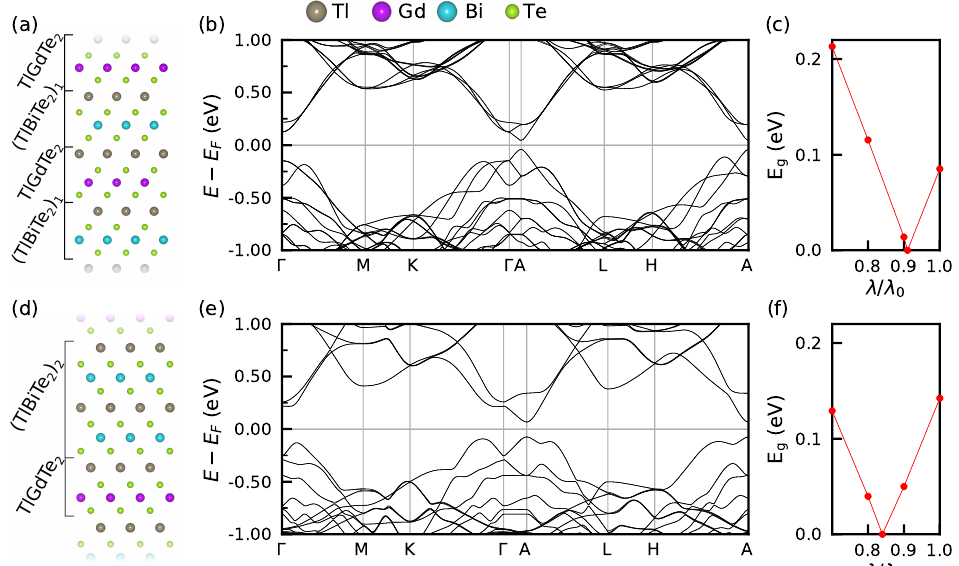
Figure 3. ( a , d ) Crystal structures of the TlGdTe 2 /(TlBiTe 2 ) n superlattices for n = 1 ( a ) and n = 2 ( d ). ( b , e ) Bulk electronic structure of the TlGdTe 2 /(TlBiTe 2 ) n superlattices for n = 1 ( b ) and n = 2 ( e ). Note that the number of bands is larger for the n = 1 system due to a larger number of the atoms in the hexagonal unit cell: 24 for n = 1 vs. 12 for n = 2. This is because the ABCABC stacking dictates that the number of atoms in the hexagonal cell is divisible by three. ( c , f ) Evolution of the bulk gap size with the change of the SOC constant λ from its natural strength λ 0 to about 0.7 λ 0 . The NCAFM spin alignment in the Gd layers is assumed in the calculations.